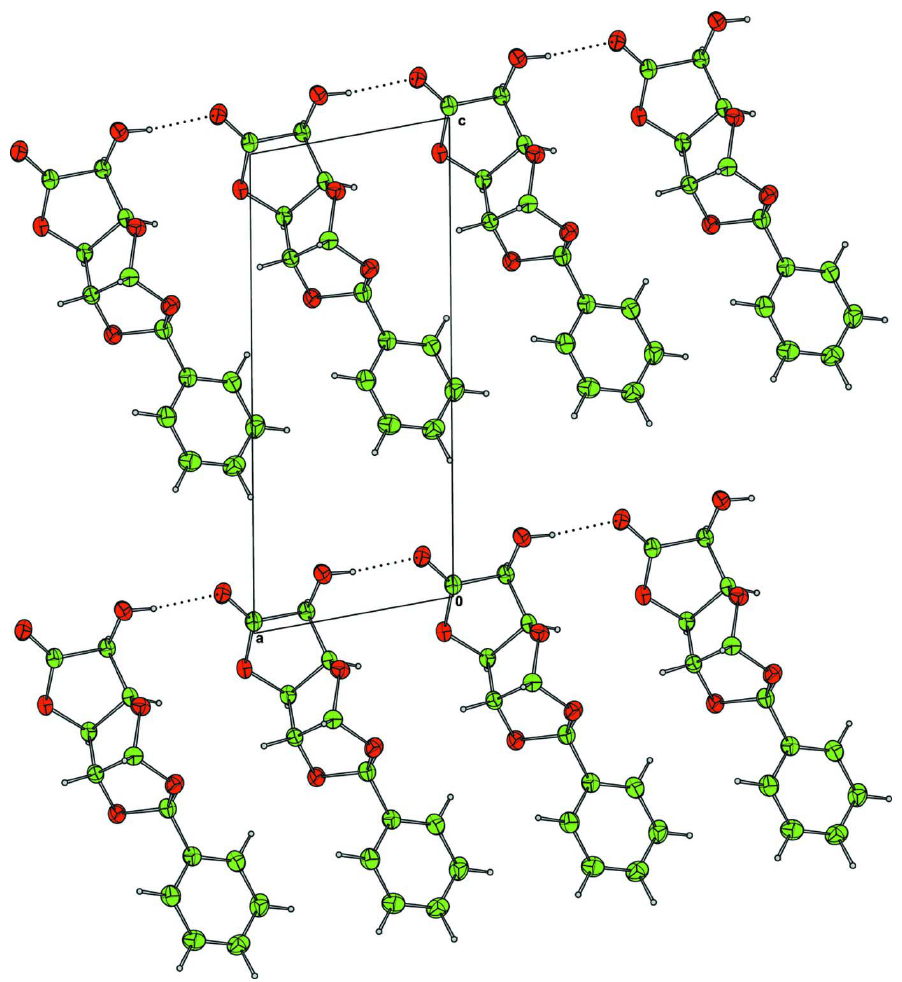
Figure 3 Packing diagram of the title compound projected along the b -axis. Hydrogen bonding is indicated by dotted